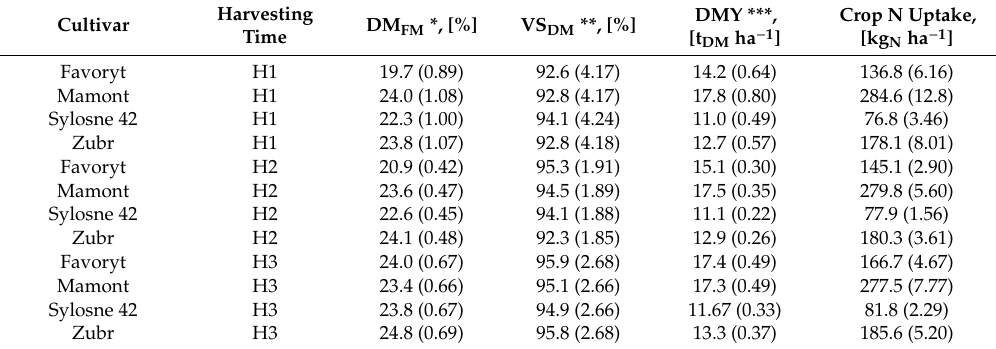
Table 4. Sweet sorghum: DM and VS- content at harvest time, dry matter yield per hectare and N-uptake. Units are given in square brackets. Values are given as mean; standard deviation is given in round